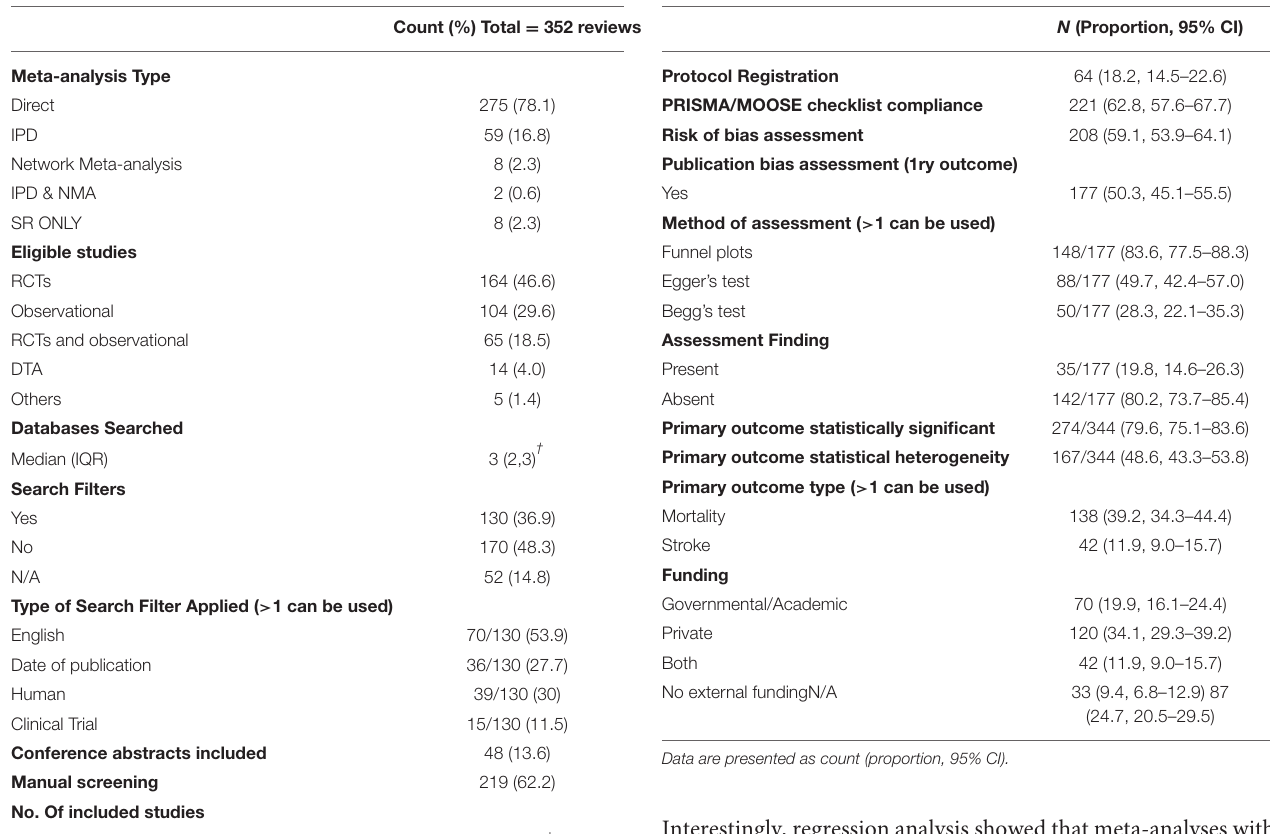
TABLE 2 | Reporting standards of the assessed systematic reviews in the current